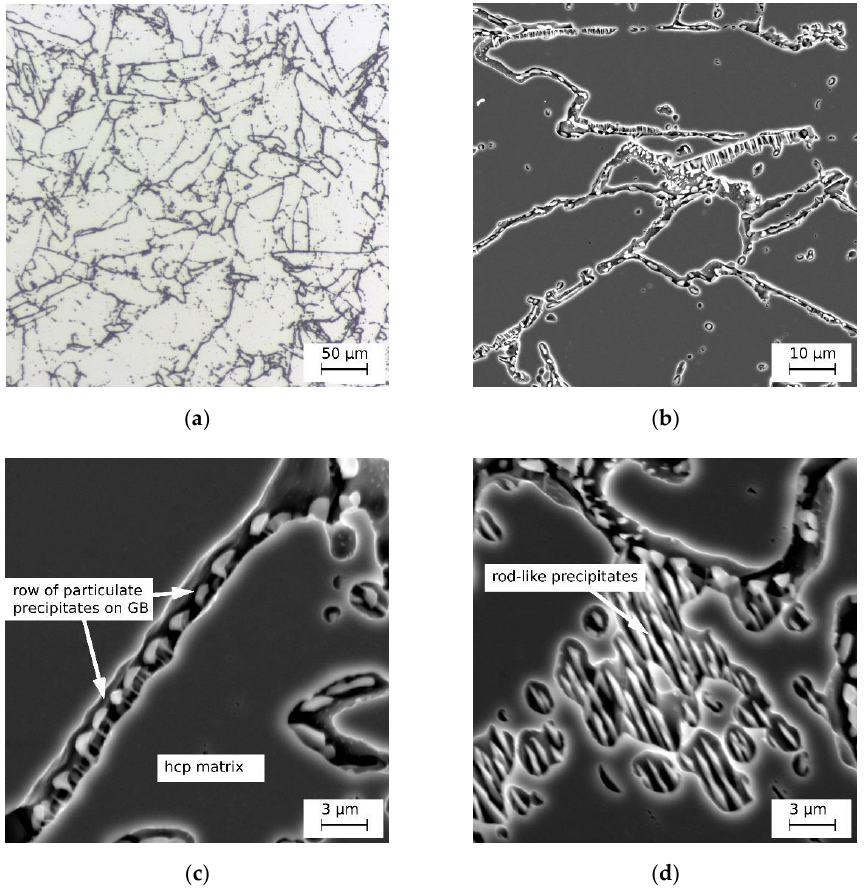
Figure 10. Microstructure of the 3D-printed alloy after 1200 °C/2 h + 900 °C/5 h heat treatment: ( a ) OM; ( b – d ) SEM.